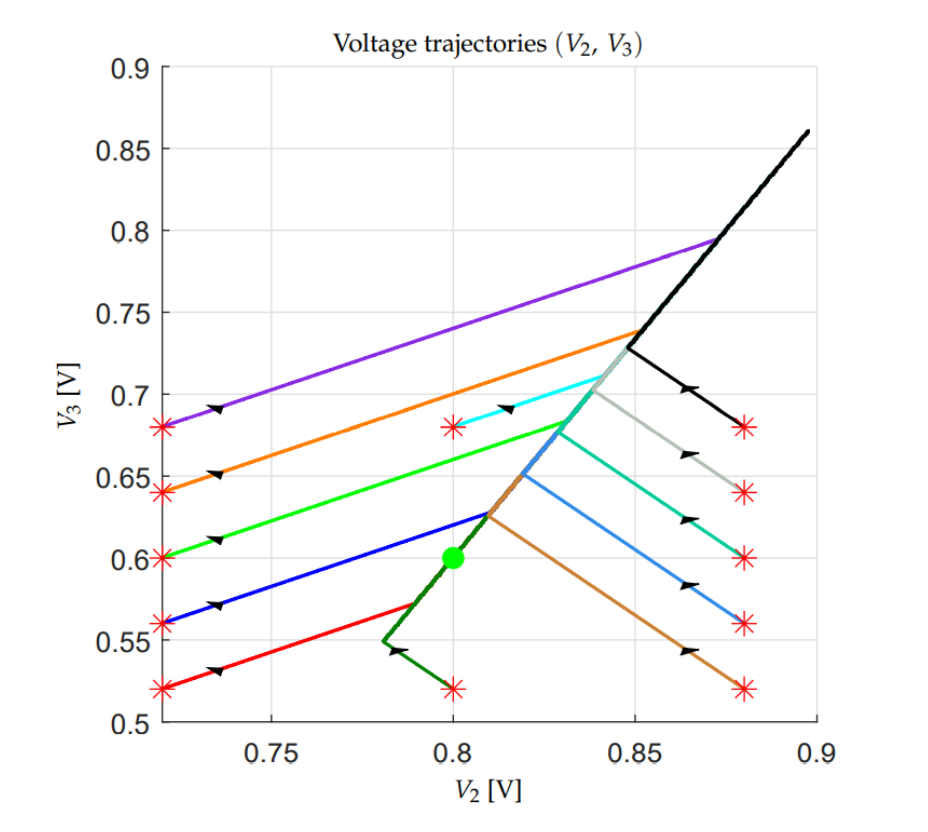
Figure 15. Instability of the Configuration Voltage Vector V m = [ 5 4 3 ] T when V d = 0.3 and I out =